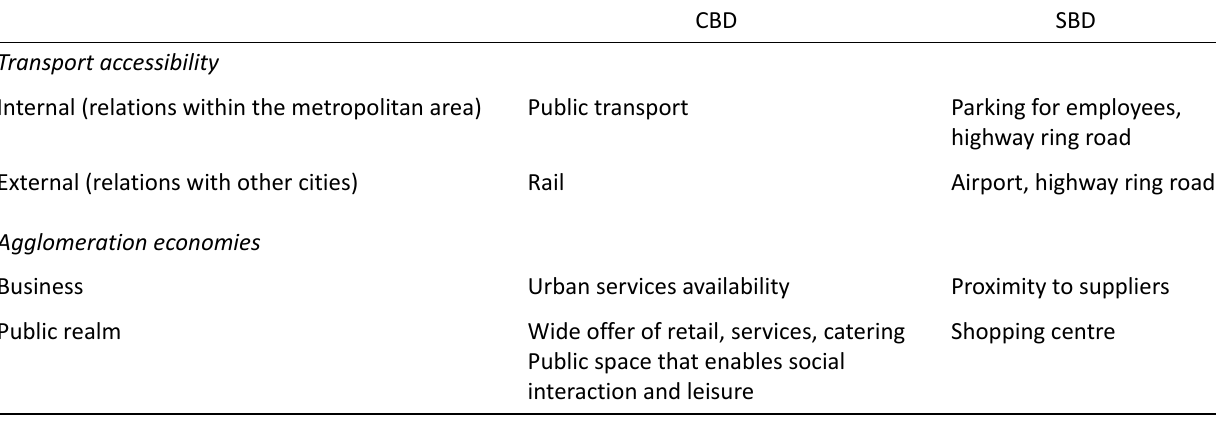
Table 3. The main differences between the two business areas in Warsaw.